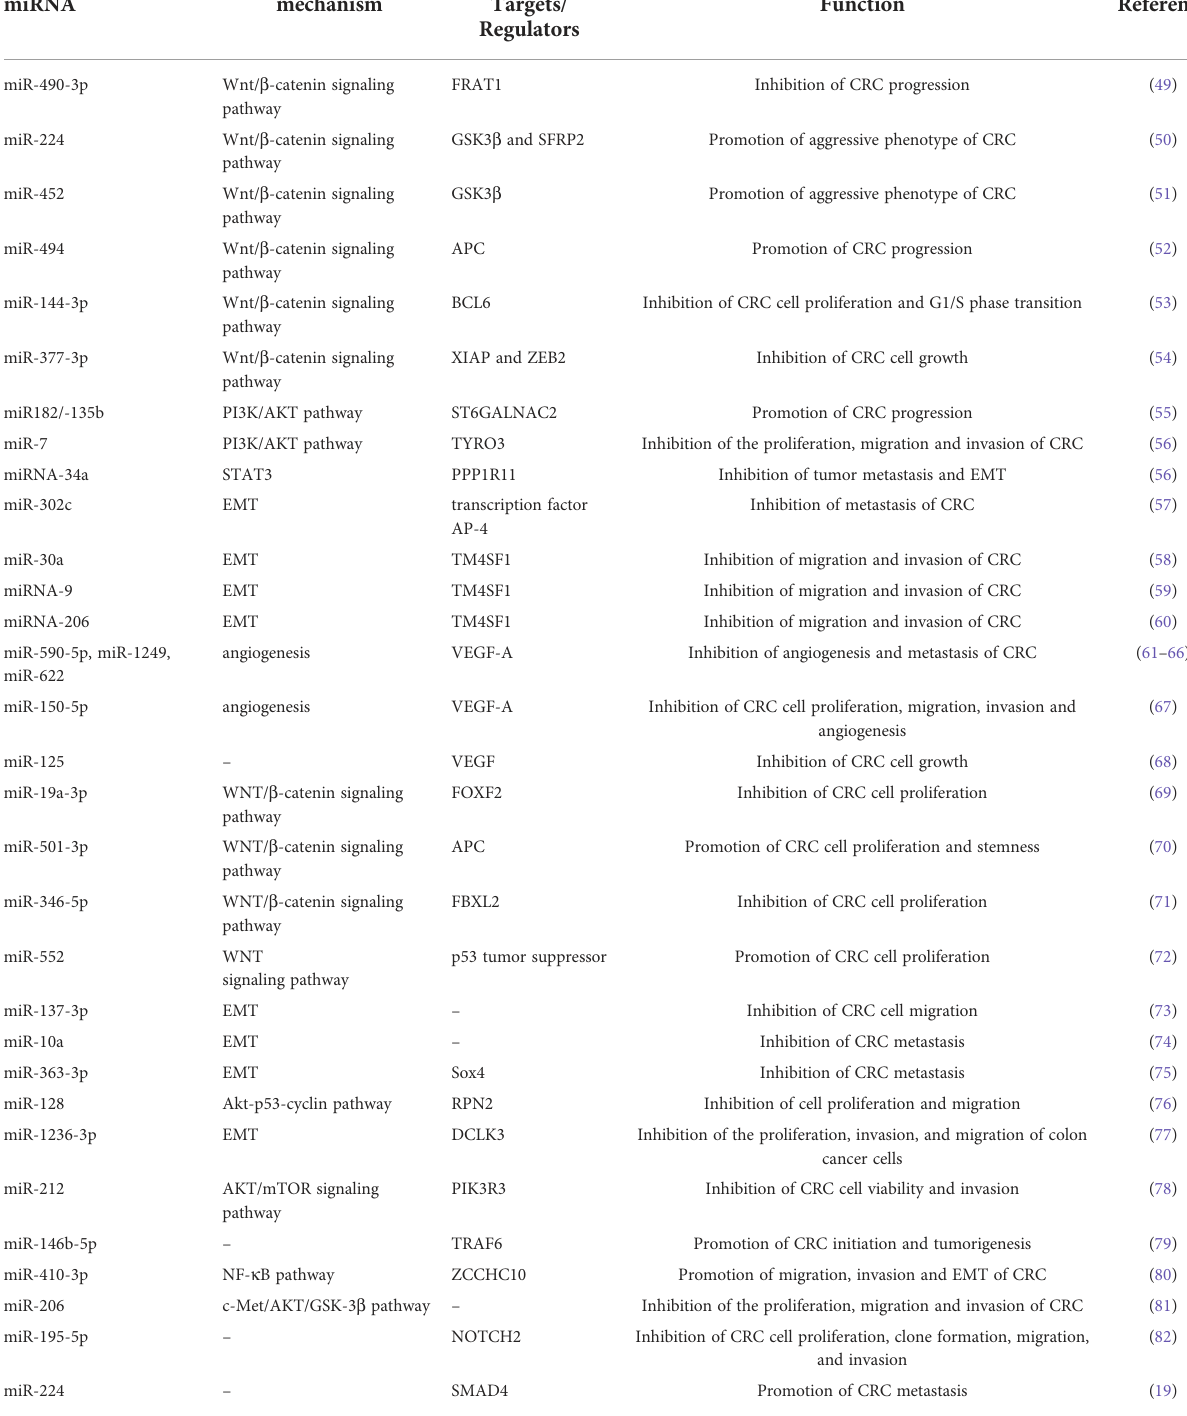
TABLE 1 A list of representative miRNAs identi fi ed in CRC that are associated with the progression/metastasis of CRC.